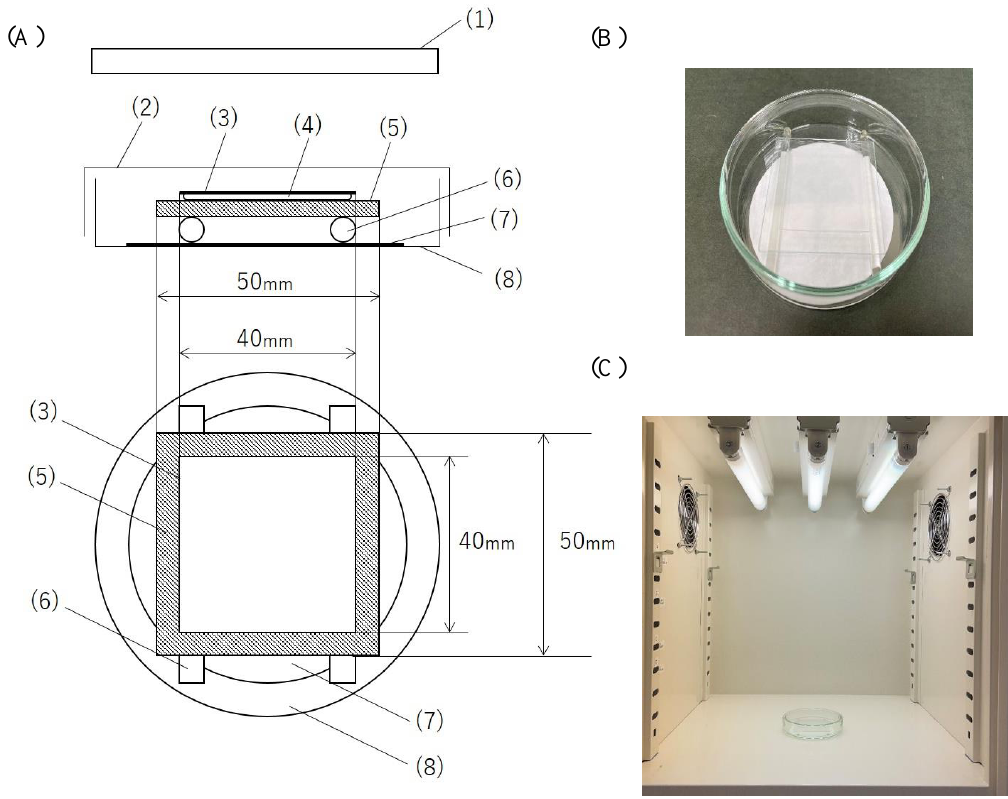
Figure 1. ( A ) Schematic of the test equipment. The test equipment was prepared in accordance with ISO 18071, a guideline of the International Organization for Standardization: (1) light source (fluorescent lamp), (2) Petri dish (lid), (3) cover film, (4) virus suspension, (5) test film, (6) glass rod, (7) paper filter, and (8) Petri dish (bottom). ( B ) A photo of a moisture chamber with a test film. ( C ) A photo of the testing